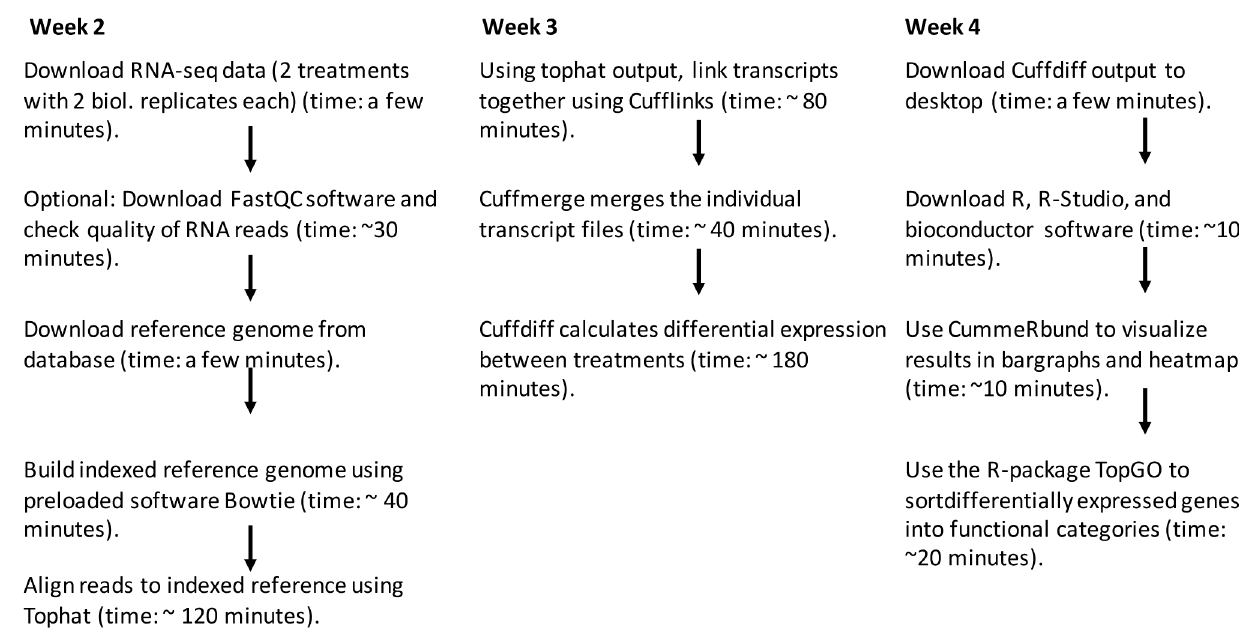
Fig 1. Flowchart depicting the compute pipeline used in the module. In Week 1, all introductory Unix exercises are performed on the student’s computer without the need for cloud computing or a Linux cluster. In Week 1, students also sign up for a free CyVerse account and start up a virtual machine.In Weeks 2 and 3, most of the cloud computingsteps are performed. The approximate compute times for each step are listed basedon the use of a virtual machinewith one CPU (“small” CyVerse instance). In betweencompute steps, students write scripts, format and verify data using command-line Unix tools, read the rationalebehindeach step, and spendsome time watchinga YouTube video (for the FastQC tutorial) and getting familiarwith specific help forums for bioinformatics questions,such as Biostars. Dependingon student preparedness and engagement, each lab session can be completedin 2.5 to 4 hours. Using more CPUs can speed up the compute time significantly for Tophat and CuffDiff analyses, which are in the current lab set-up “overnight” steps separating labs. CPU, central processing